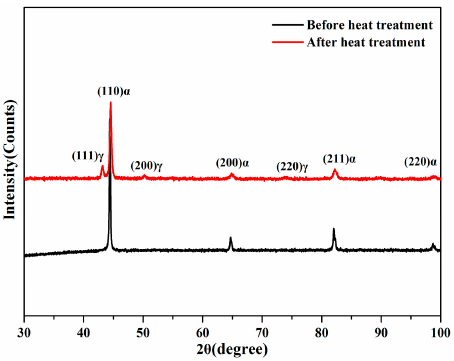
Figure 5. SEM micrographs of the microstructure in the tested steel. ( a ) Before heat treatment and ( b ) after heat treatment.